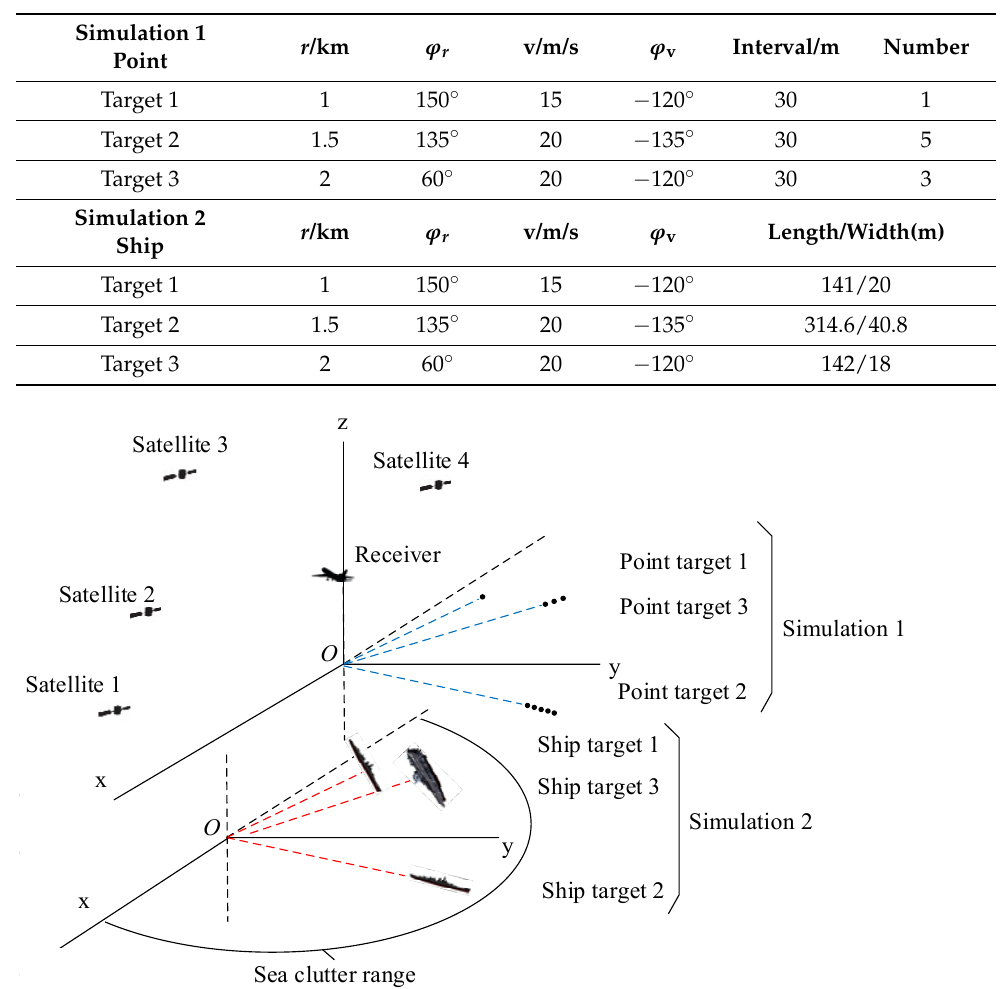
Table 2. Target parameter.